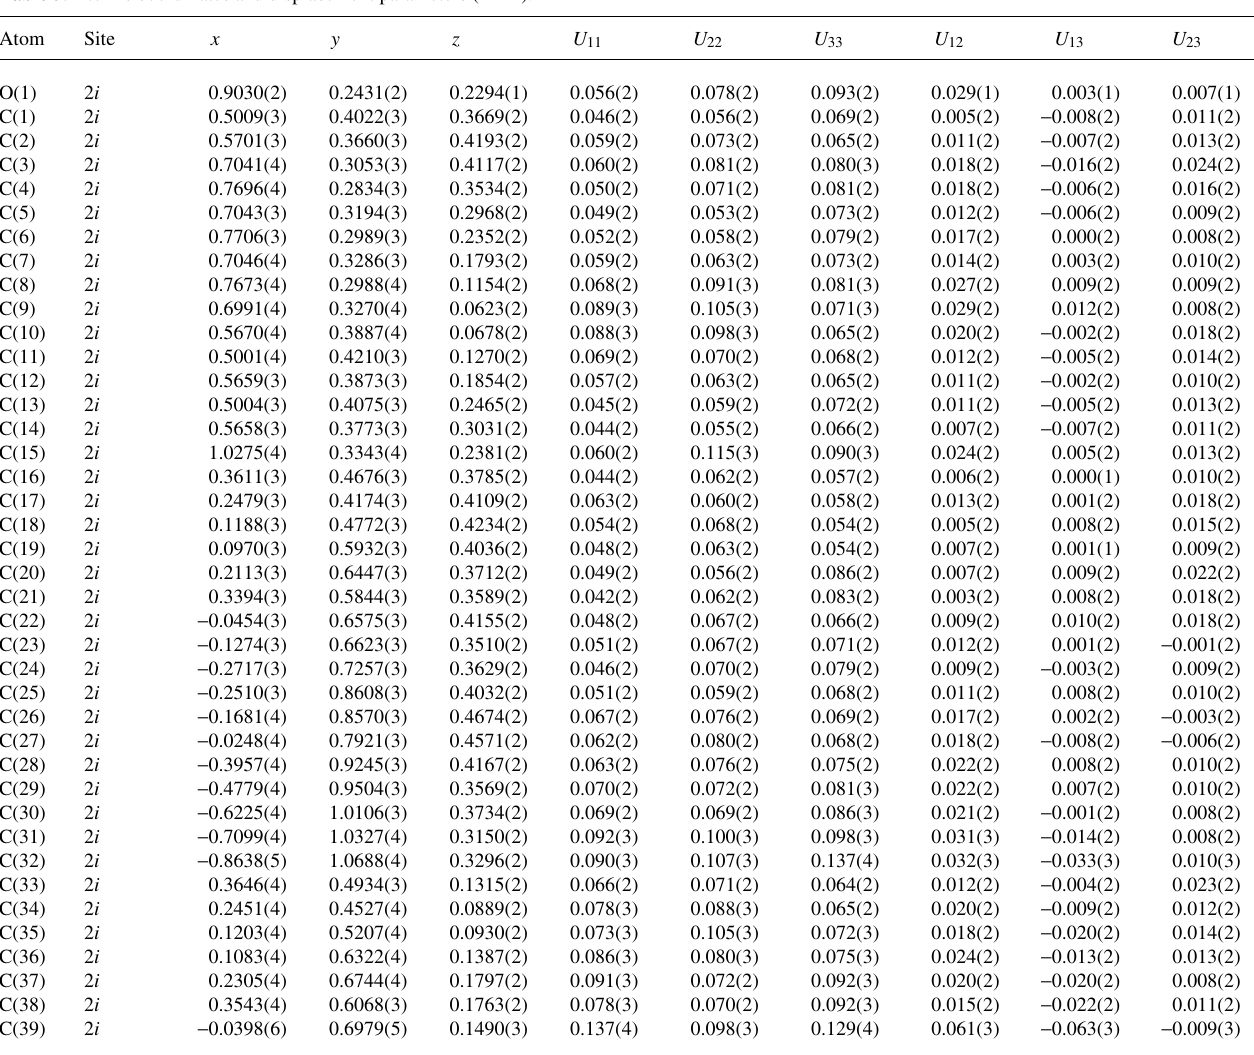
Table 3. Atomic coordinates and displacement parameters (in Å 2 )